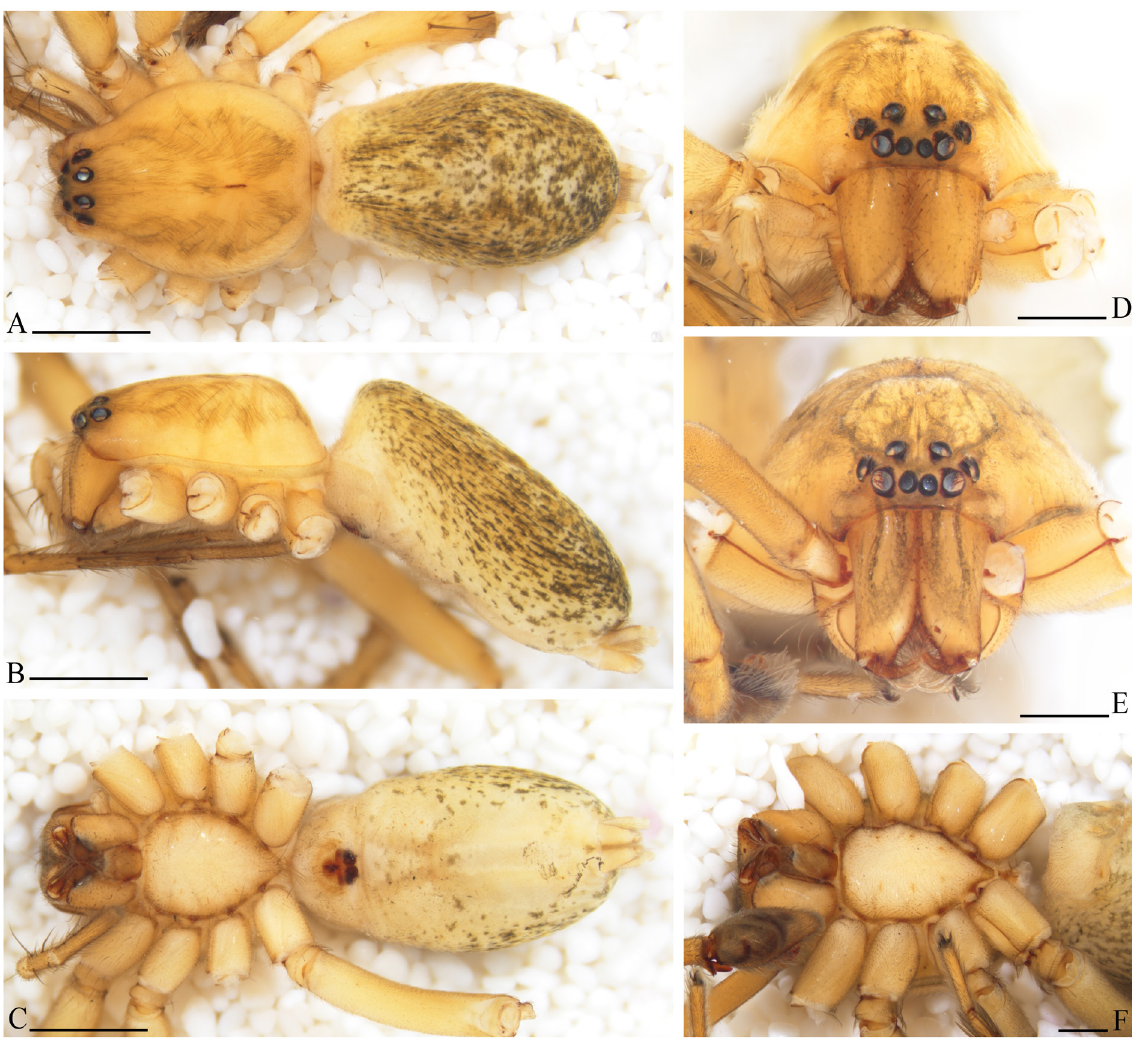
Fig. 45. Anyphaena tonoi sp. nov. A–D . Paratype, ♀ (CNAN-T01576). E–F . Paratype, ♂ (CNAN-T01575). A . Dorsal habitus. B . Lateral habitus. C . Ventral habitus. D . Prosoma, anterior view. E . Prosoma, anterior view. F . Prosoma, oblique view. Scale bars: A–C = 1.0 mm; D–F = 0.5